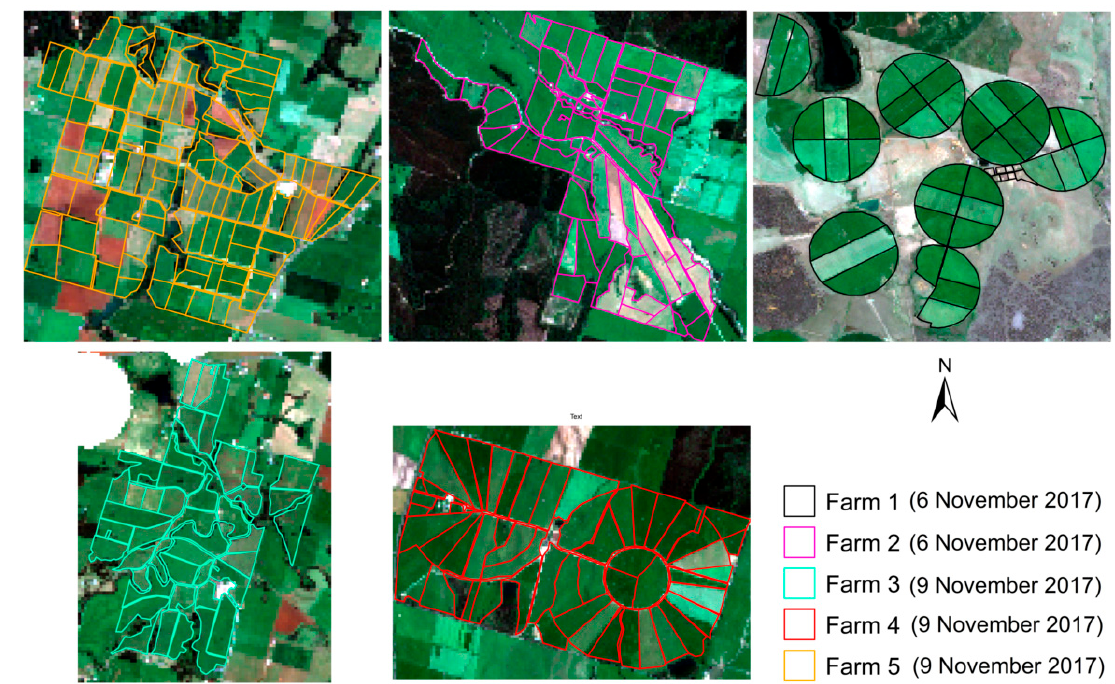
Figure 2. Colour-composite images of Sentinel-2 bands 4, 3 and 2 (RGB) showing the five farms used as the study